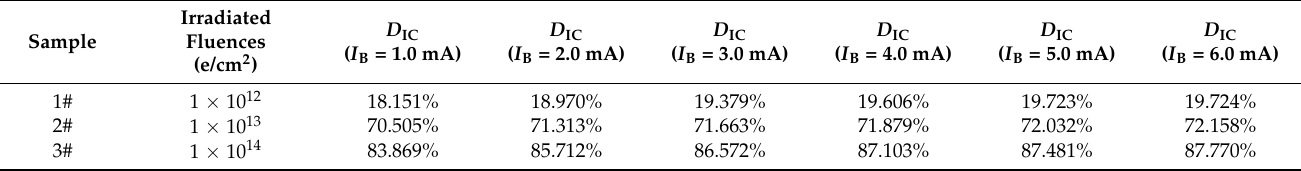
Table 1. Attenuation rate of I c for SMST after